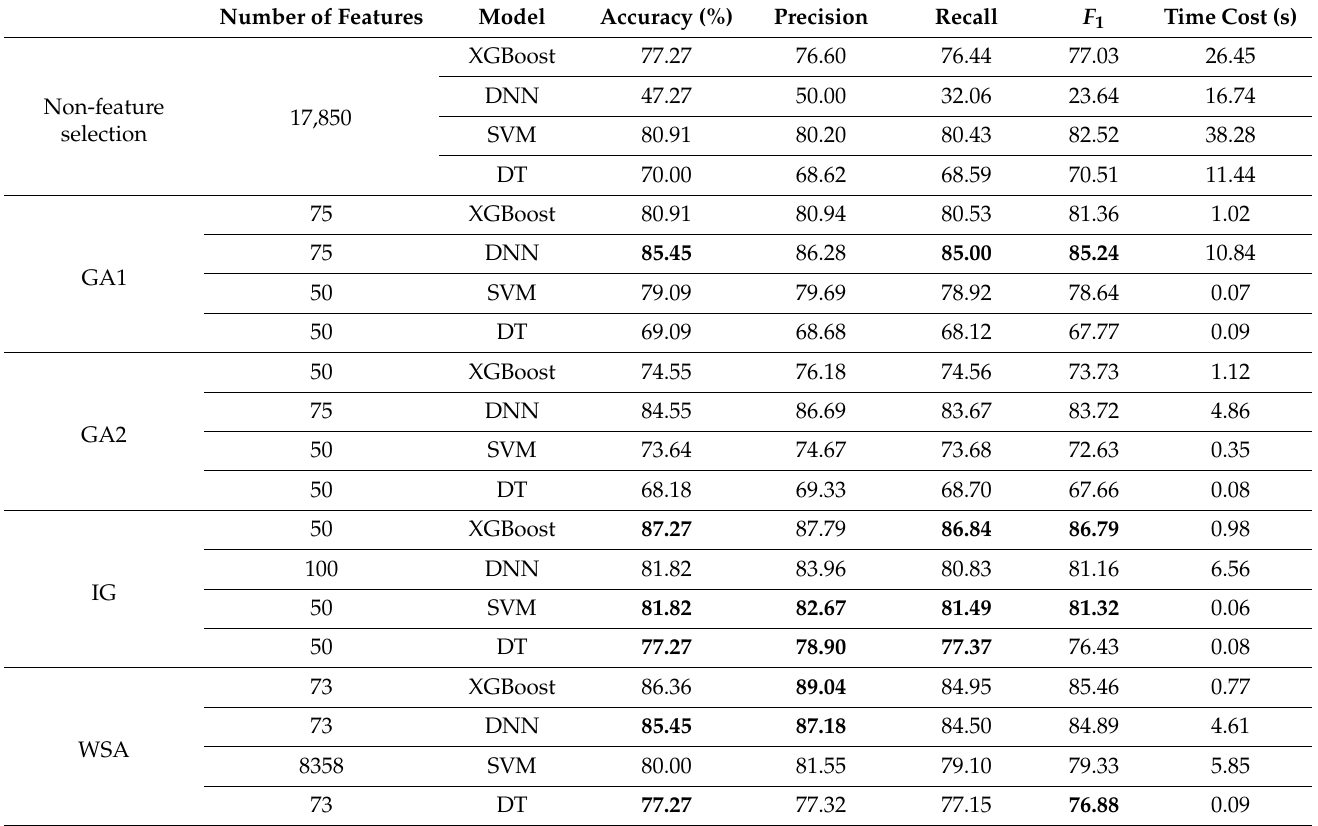
Table 5. Comparison of accuracy, precision, recall, F 1 score, and time cost of machine learning for feature selection methods and non-feature